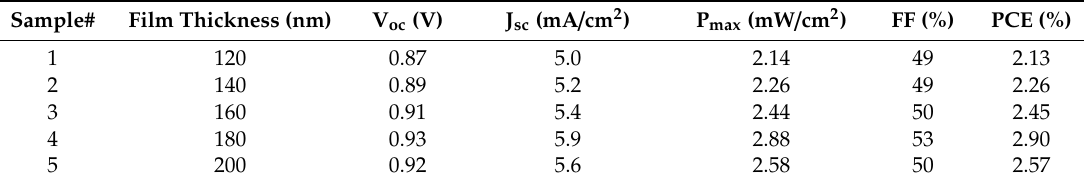
Table 1. Comparison of di ff erent parameters of the fabricated BHJ solar cells as a function of PFB–PCBM film thickness.